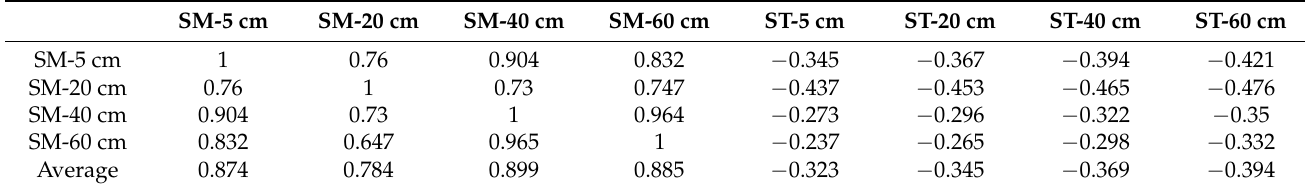
Table 5. Spearman correlation coefficients of environmental factors (Part I).